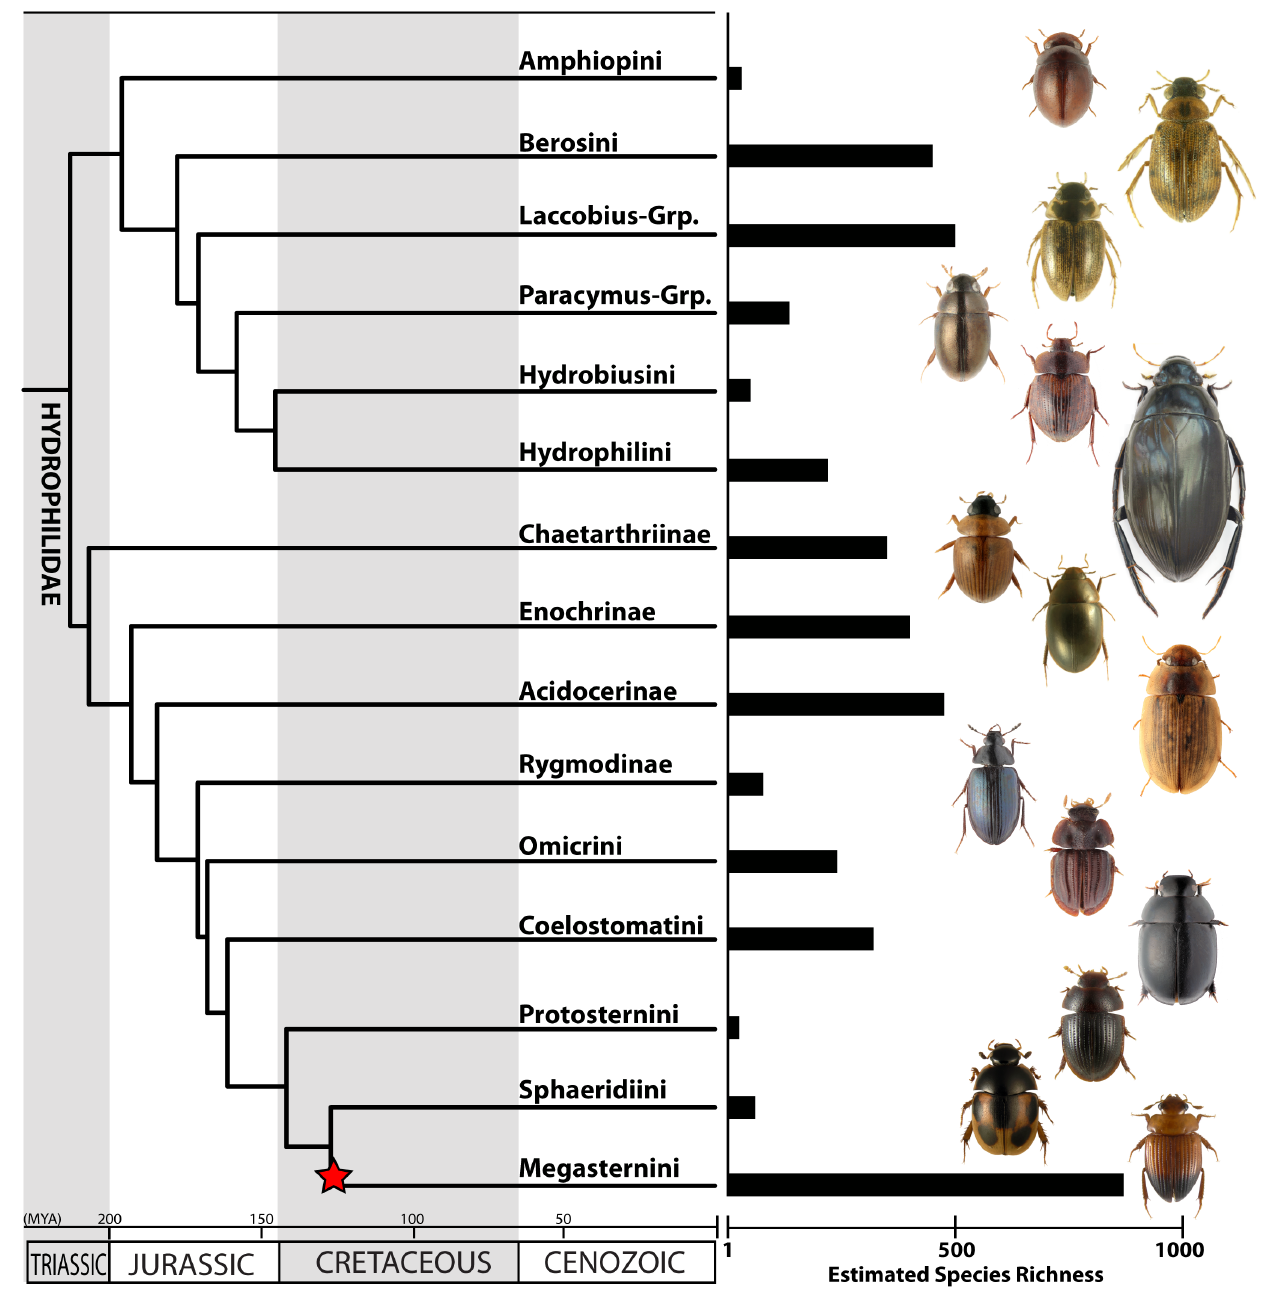
Figure 3. Time-calibrated phylogeny for major lineages of Hydrophilidae, along with estimated species richness values. The star indicates the location of the diversification rate increase determined by our MEDUSA